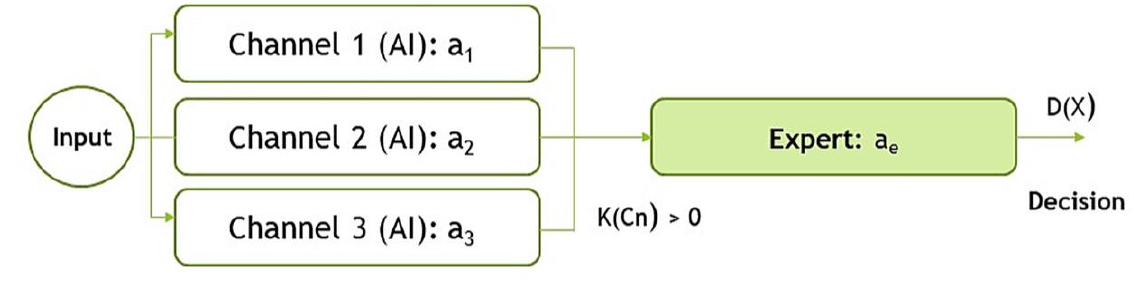
Figure 5. Multi-channel AI decision system with expert